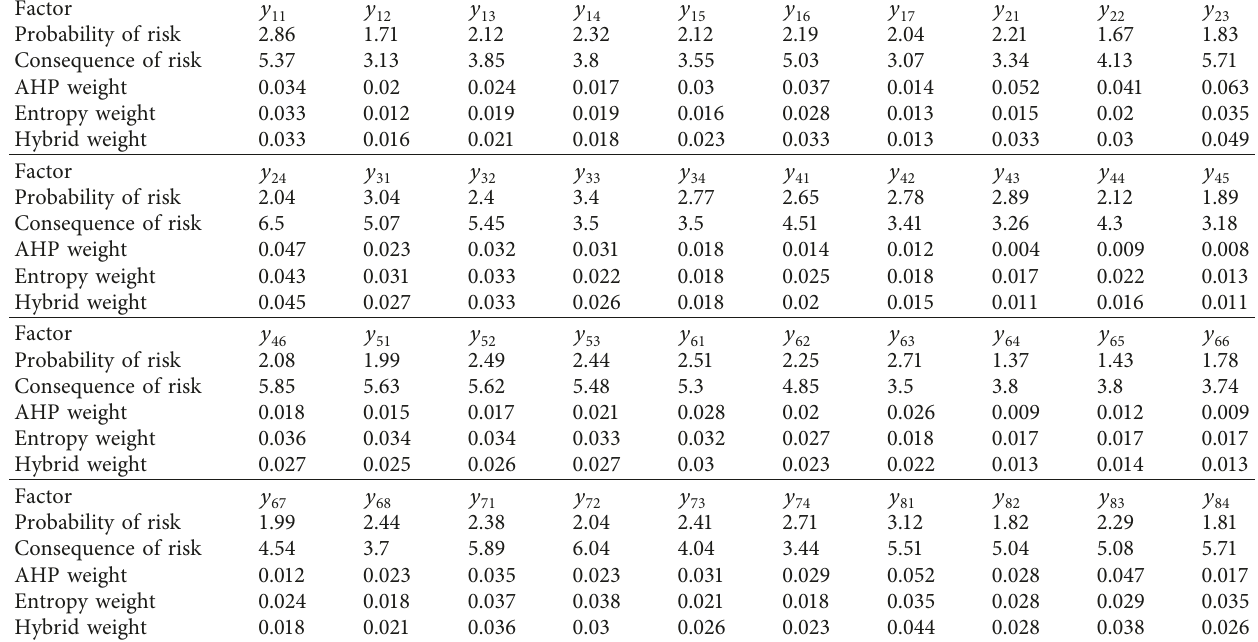
Table 2: Index weight of each risk factor and initial risk value.